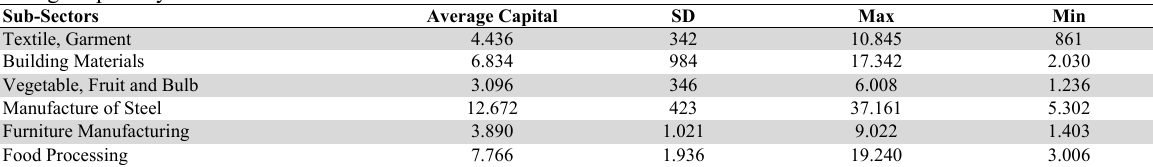
Average capital by Sub-sectors Unit: Million VND Sub-Sectors Average Capital